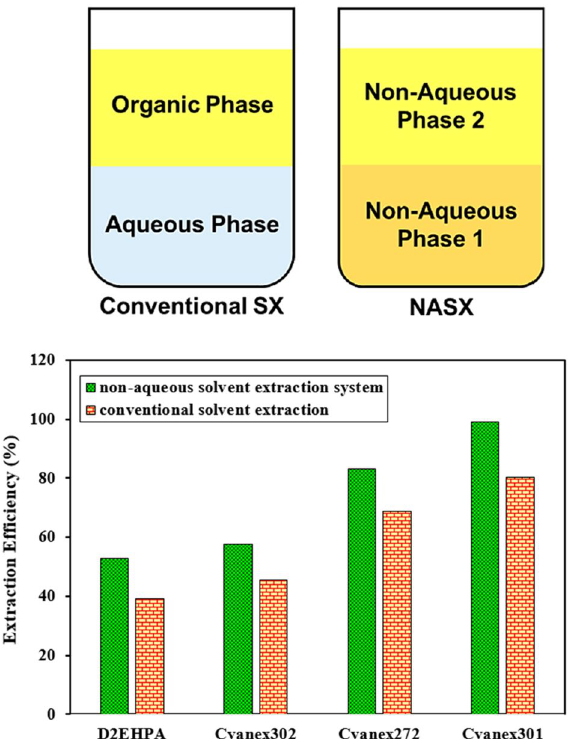
Figure 1. Comparison of (left) conventional solvent extraction (SX) and non-aqueous solvent extraction (NASX) systems [(Co(II)) = 700 ppm; 80%EG + 20%Water in NASX and 100% Water in SX; pH = 3; (LiCl) = 1 M; 0.05 M concentration for all